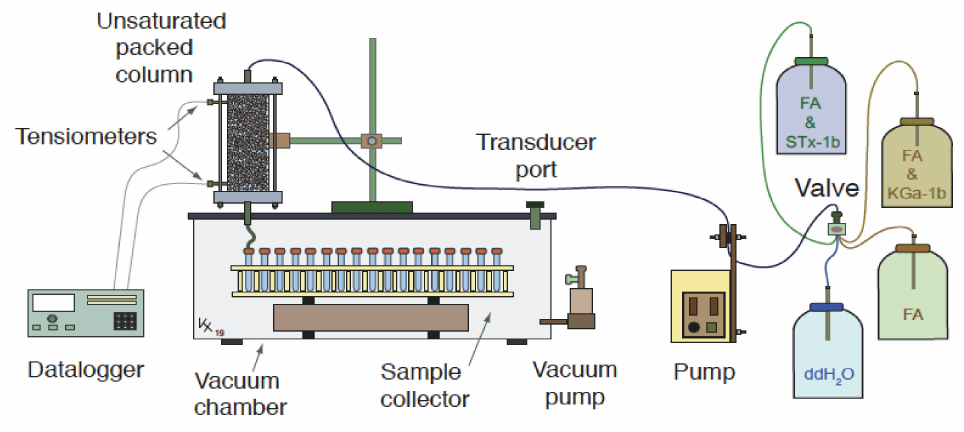
Figure 1. Schematic illustration of the experimental